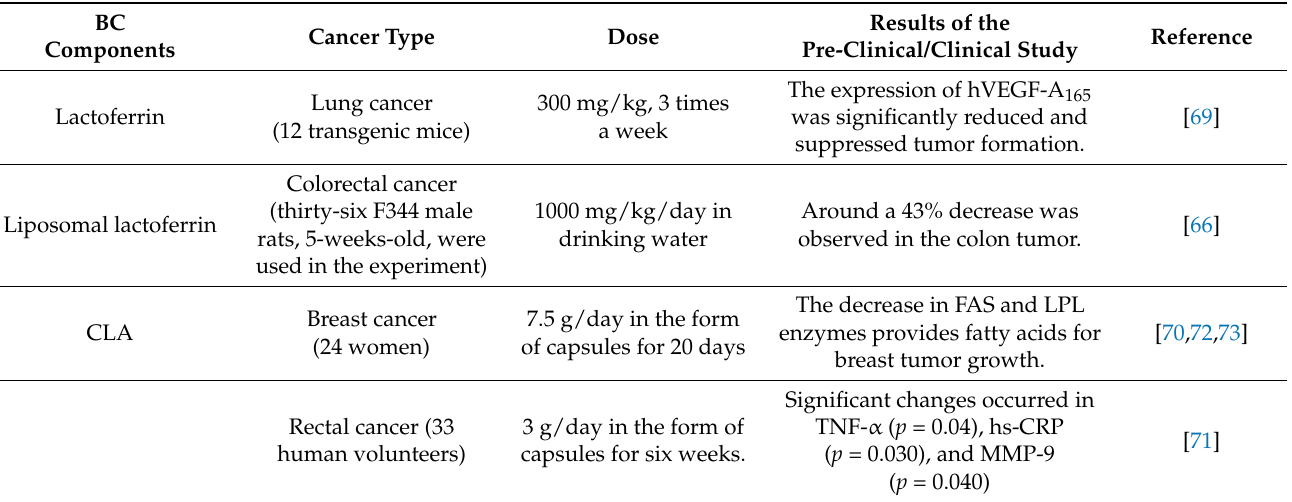
Table 3. Effects of BC components on some cancer types in humans and animals, both pre-clinically and clinically.